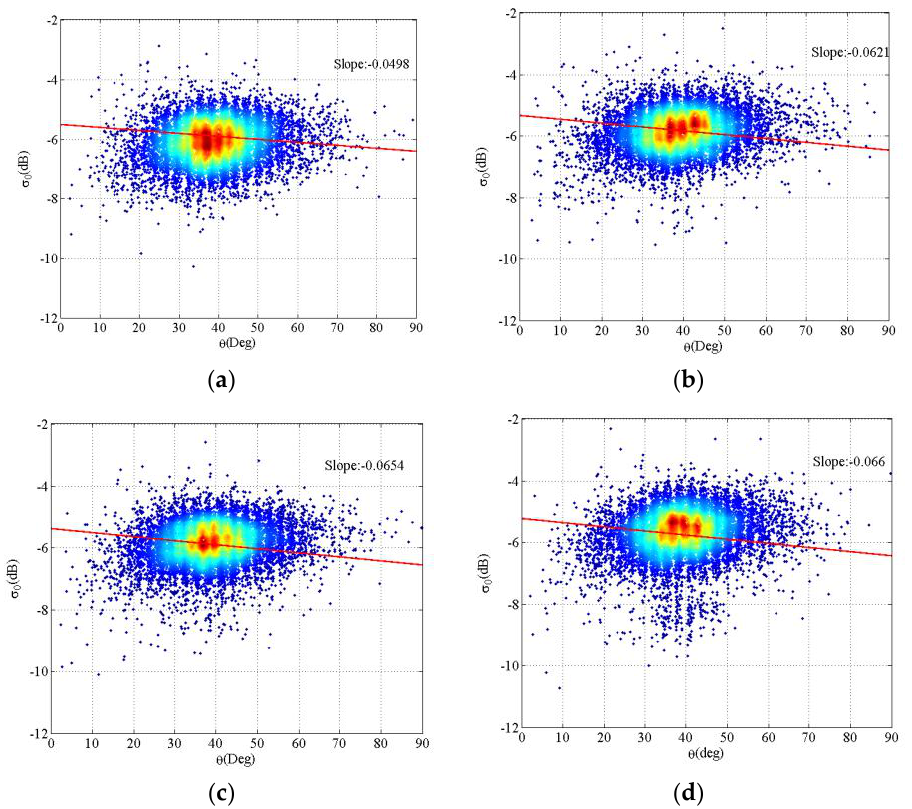
Figure 9. Time series analysis of backscatter coefficient on RADARSAT-2 data sets for Yigen: ( a ) 23 May 2013; ( b ) 6 June 2013; ( c ) 10 July 2013; and ( d ) 3 August 2013. Table 5. Time series analysis of backscatter coefficient on RADARSAT-2 data sets for Yigen. Calculation time: 32 min.